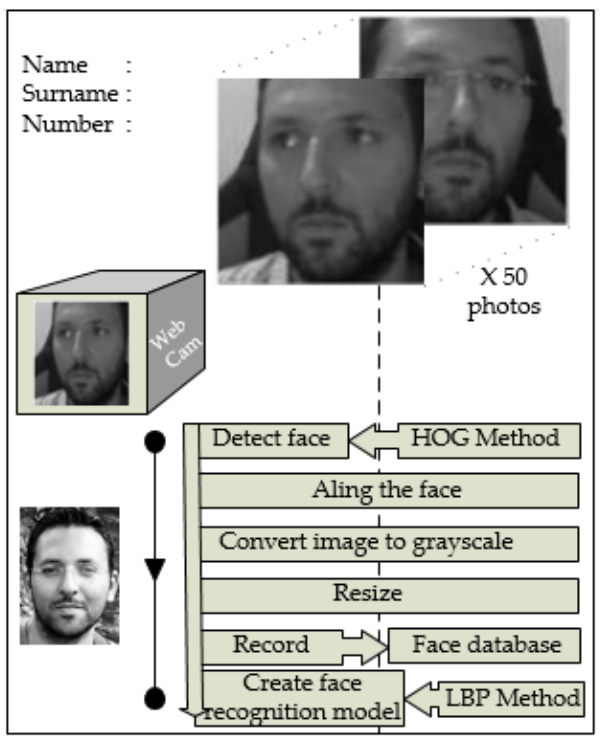
Figure 10. Flowchart of face recognition model preparation module of SECS.